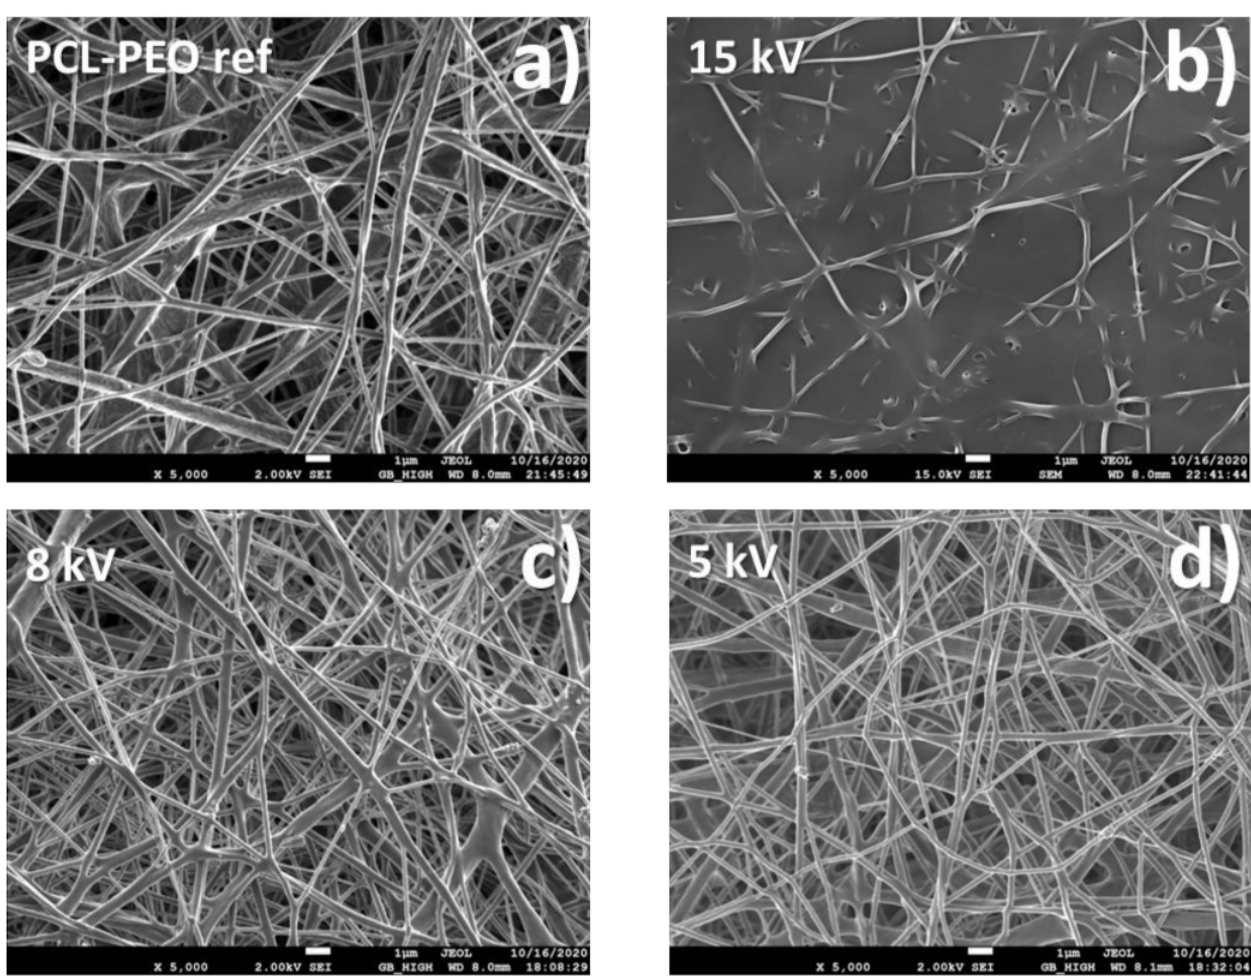
Figure 4. SEM micrographs of samples PCL/PEO-ref ( a ), PCL/PEO-Ti0.5-Ag15kV ( b ), PCL/PEO- Ti0.3-Ag-8kV ( c ) and PCL/PEO-Ti0.3-Ag-5kV ( d